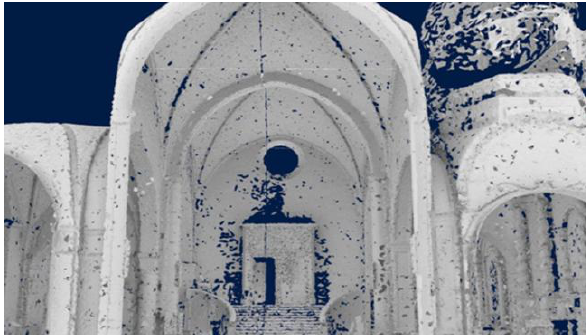
Figure 8. A general view of the achieved 3D model using the script